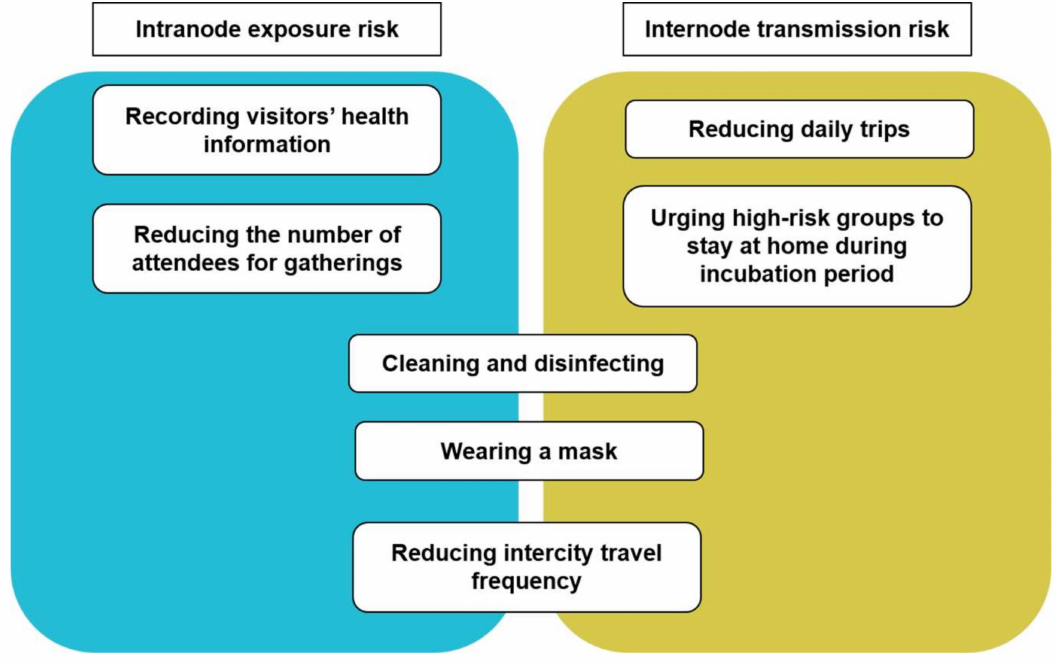
Figure 3. Preventive measures against pandemics in the early